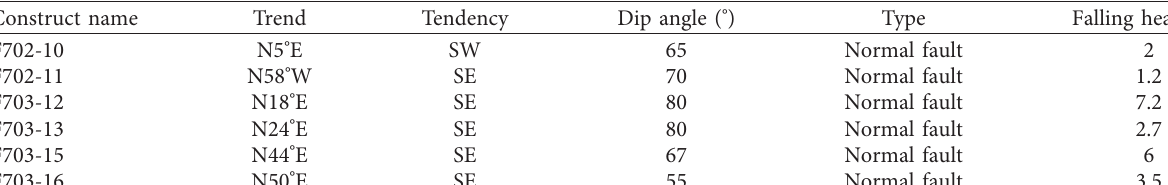
Table 1: Occurrence characteristics of weak zone in 182703 working face.